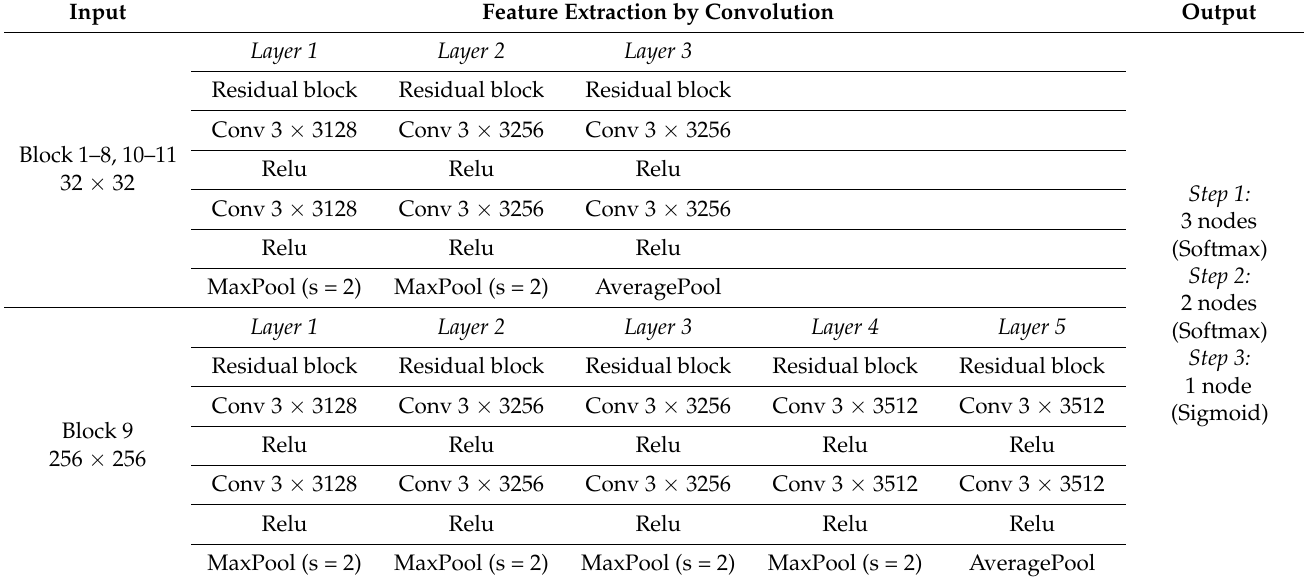
Table 3. Bone age range of each